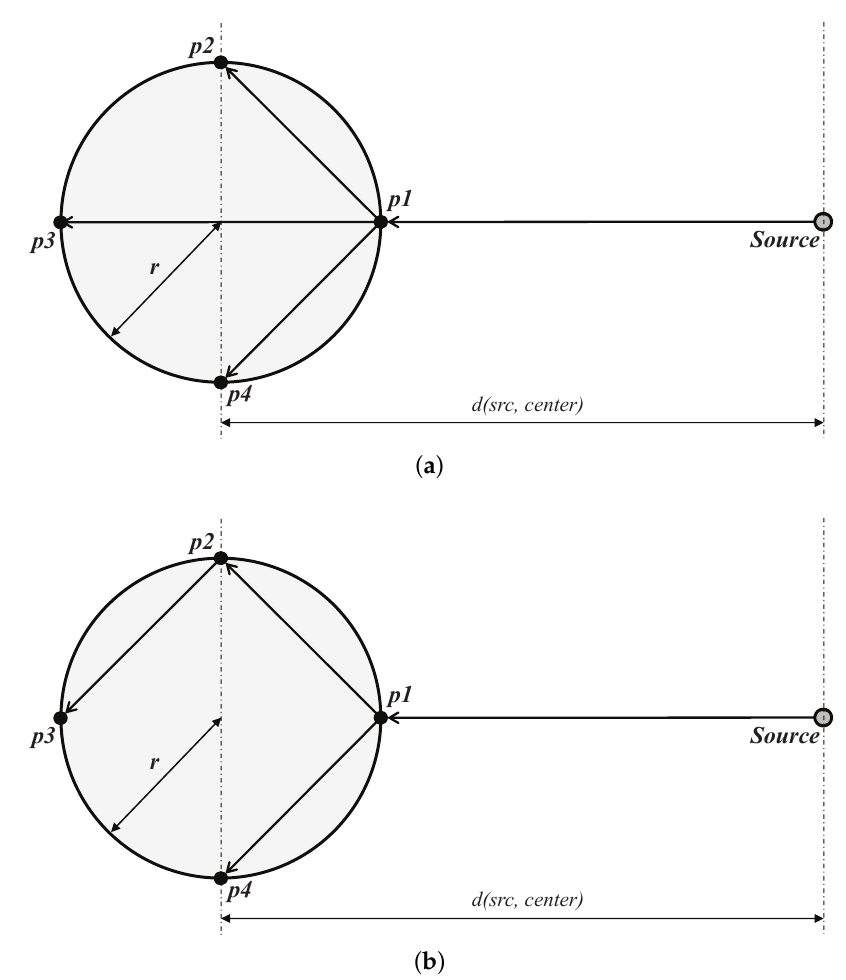
Figure 4. The extended schemes: ( a ) EAR2M_R and ( b )